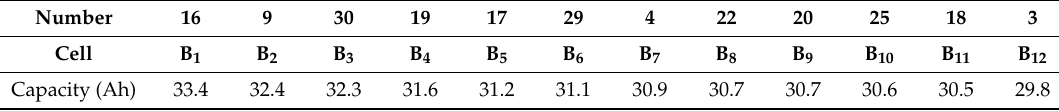
Figure 3. New rated capacity distribution of 30 retired batteries. Table 1. New rated capacities of the selected 12 retired cells.